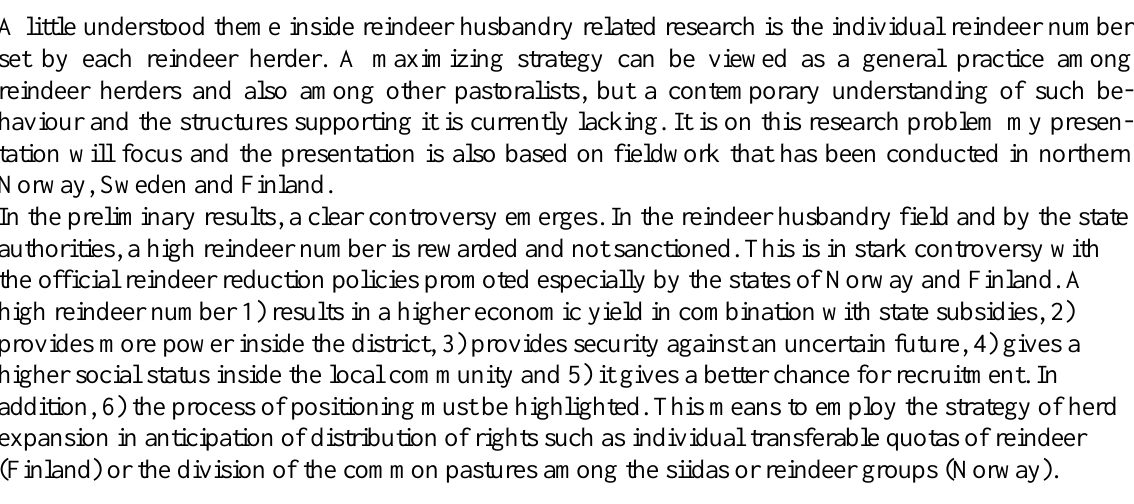
Et lite forstått tema innenfor reindriftsforskningen er hvordan reintallet til den individuelle rein- driftsutøver blir fastsatt og hvorfor det er viktig å eie en stor reinflokk. En maksimeringsstrategi kan bli sett på som en generell strategi hos de fleste pastoralister, inkl. reindriftsutøvere, men en forståelse av denne strategien og det rammeverket som støtter den, mangler. Dette er problematikken som denne presentasjonen vil prøve å utdype. Feltarbeid er utført i flere samiske reinbeitedistrikter i Norge, Finland og Sverige. I de preliminære resultatene fra feltarbeidet finner man kontroversielle uttalelser angående reintall. Innenfor reindriftsnæringen og innenfor det statlige forvaltningssystemet blir et høyt reintall belønnet i stedet for sanksjonert. Dette er i sterk kontrast til den statlige politikken som prøver å få både reintallet og antall reineiere redusert. Et høyt reintall 1) gir blant annet et høyere økonomisk resultat i sammenheng med subsidier/kompensasjoner, 2) gir mer makt innenfor distriktet og mellom distriktene, 3) gir mer sikkerhet mot uforutsigbare forandringer, 4) gir høyere sosial status i lokal- samfunnet og 5) gir bedre mulighet for rekruttering. I tillegg 6) så må prosessene rundt posisjonering bli understreket. Posisjonering i reindriftsnæringen skjer ved at reineiere prøver å maksimere sitt rein- tall i vente på at rettigheter til beite og reintall vil bli individuelt fordelt. Alle disse prosessene støtter det å eie en stor